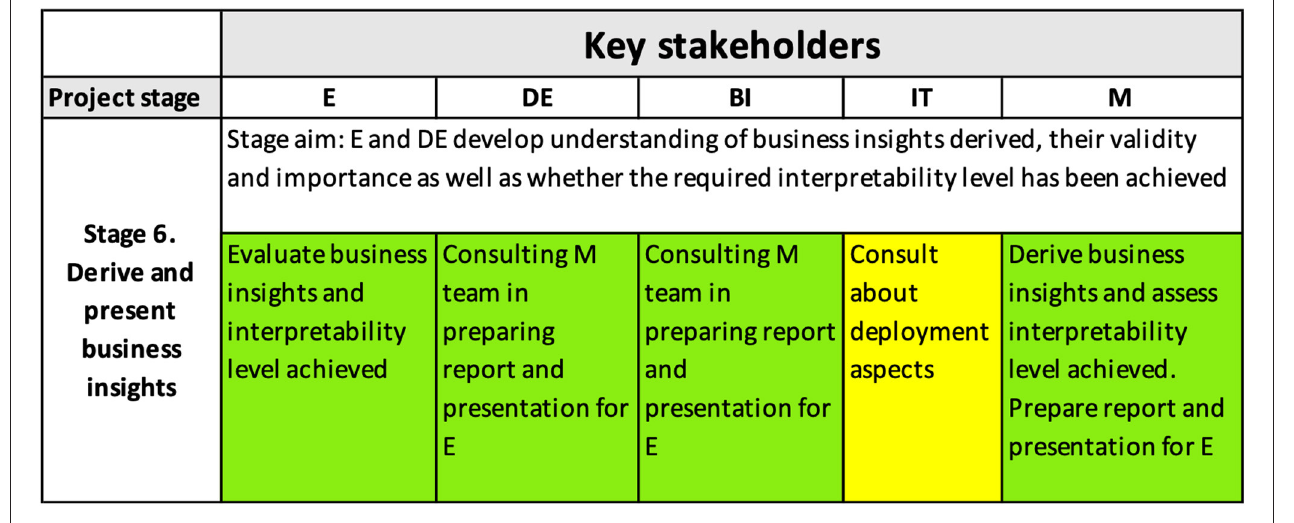
FIGURE 8 | Interpretability matrix content for Stage